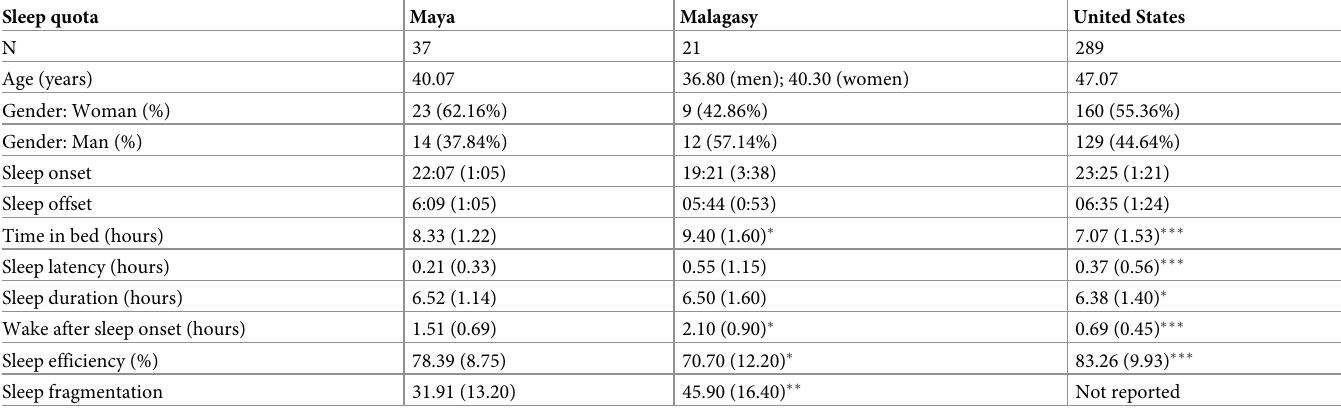
Table 1. Sleep quotas comparing the full Maya sample with Malagasy participants [16] and an industrial sample from the United States. Sleep quota